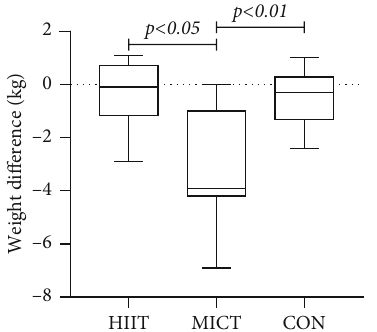
Figure 3: Comparison of weight di ff erence between groups after the intervention.